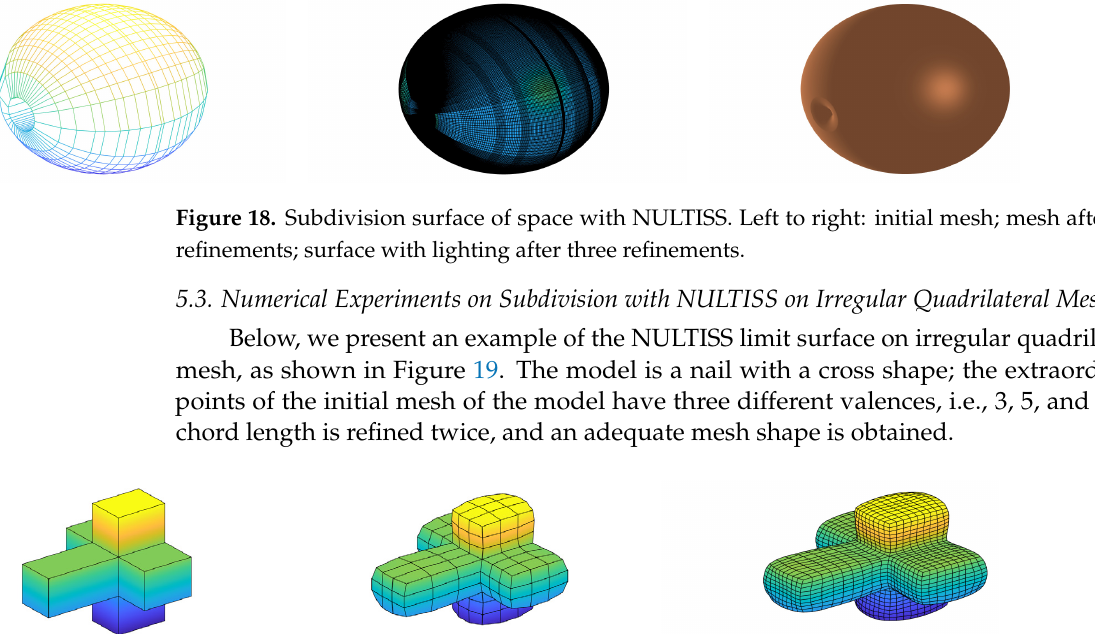
Figure 19. Subdivision surface of space with NULTISS. Left to right; initial mesh; mesh after one refinement; mesh after two refinements.